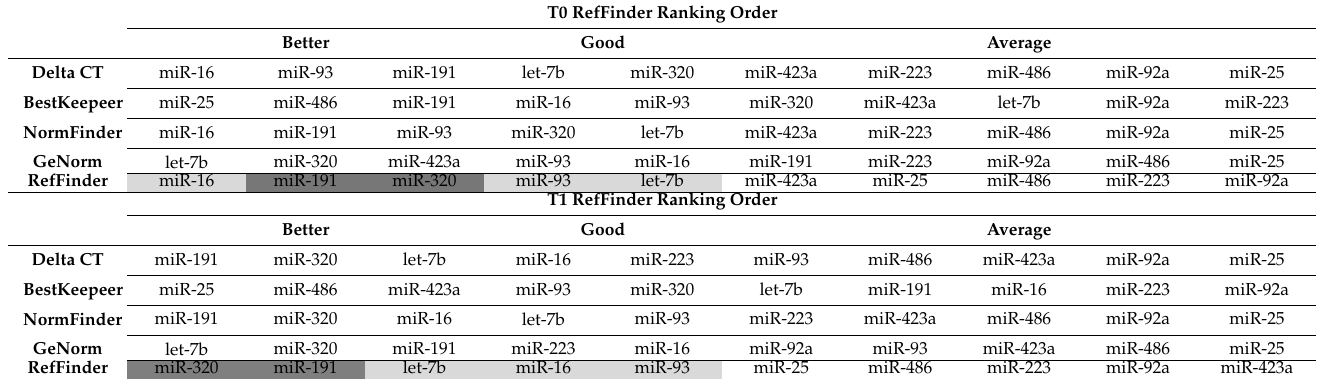
Table 4. RefFinder comprehensive ranking. The tables show the ranking of stability values assigned by RefFinder at T0 (up) and T1 (down). The RefFinder method recommends a comprehensive ranking that rates miRNAs as best, good, and average by ordering miRNAs from most stable to least stable. The first five miRNAs (gray box) have the best stability characteristics at both T0 and T1; in the dark gray box are the miRNAs with the best characteristics at both T0 and